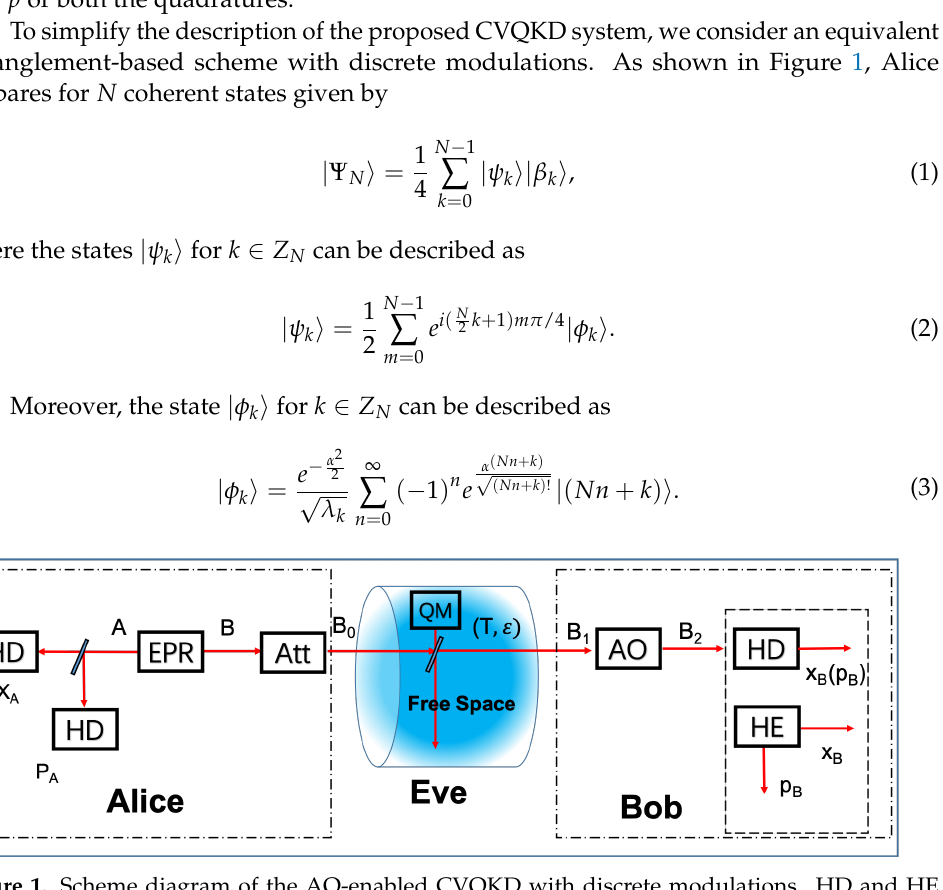
Figure 1. Scheme diagram of the AO-enabled CVQKD with discrete modulations. HD and HE denote homodyne detection or heterodyne detection, Att denotes attenuation, QM denotes quantum memory, and EPR is a two-mode squeezed vacuum (EPR)